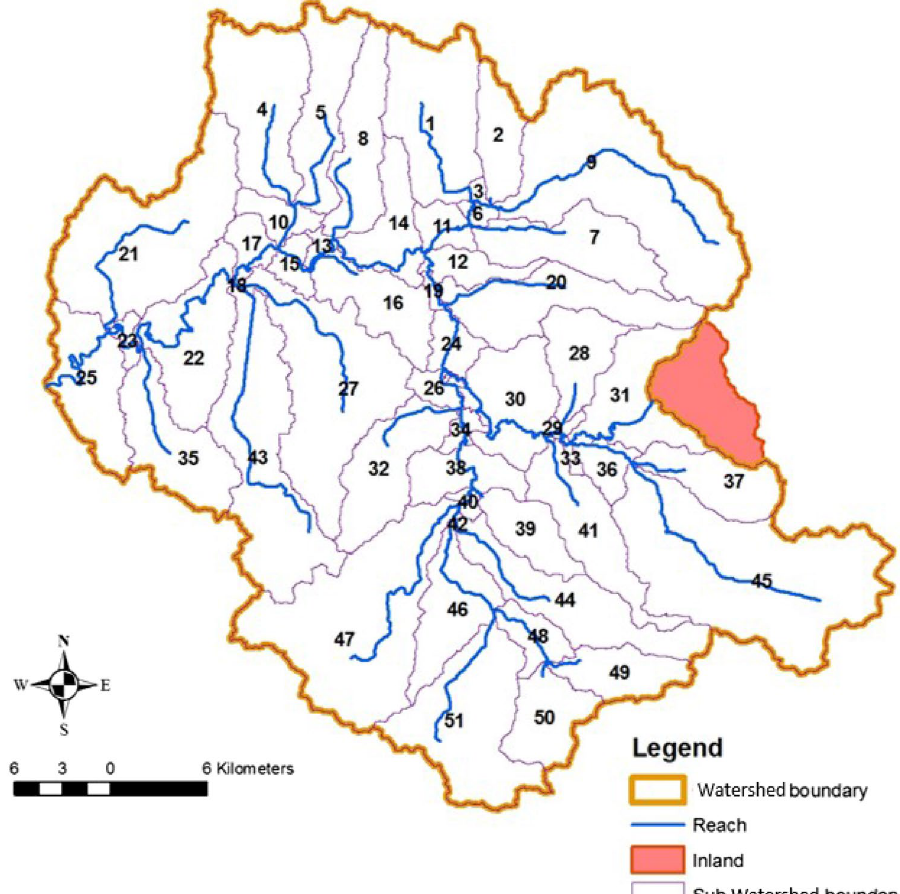
Fig. 7 Sub-watershed descrip- tion in the